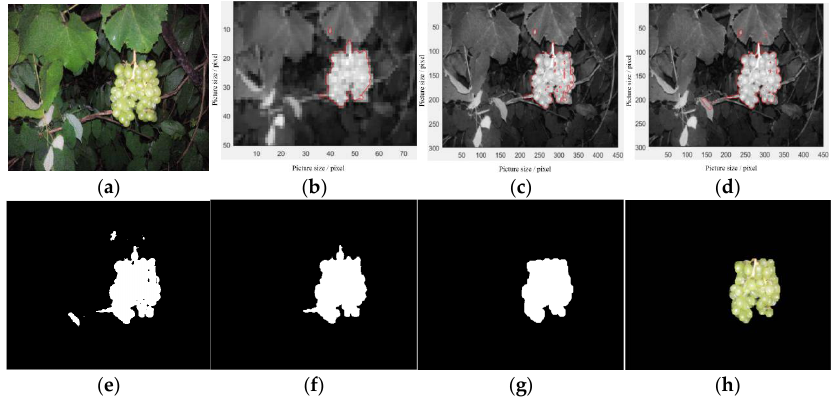
Figure 8. Detection results of the improved algorithm. ( a ) Night-time image; ( b ) initial iteration result; ( c ) rough contour; ( d ) further iteration result; ( e ) binary image; ( f ) Bbinary image after retaining the largest region and filling holes; ( g ) binary image after opening operation and closing operation; ( h ) grape fruit.